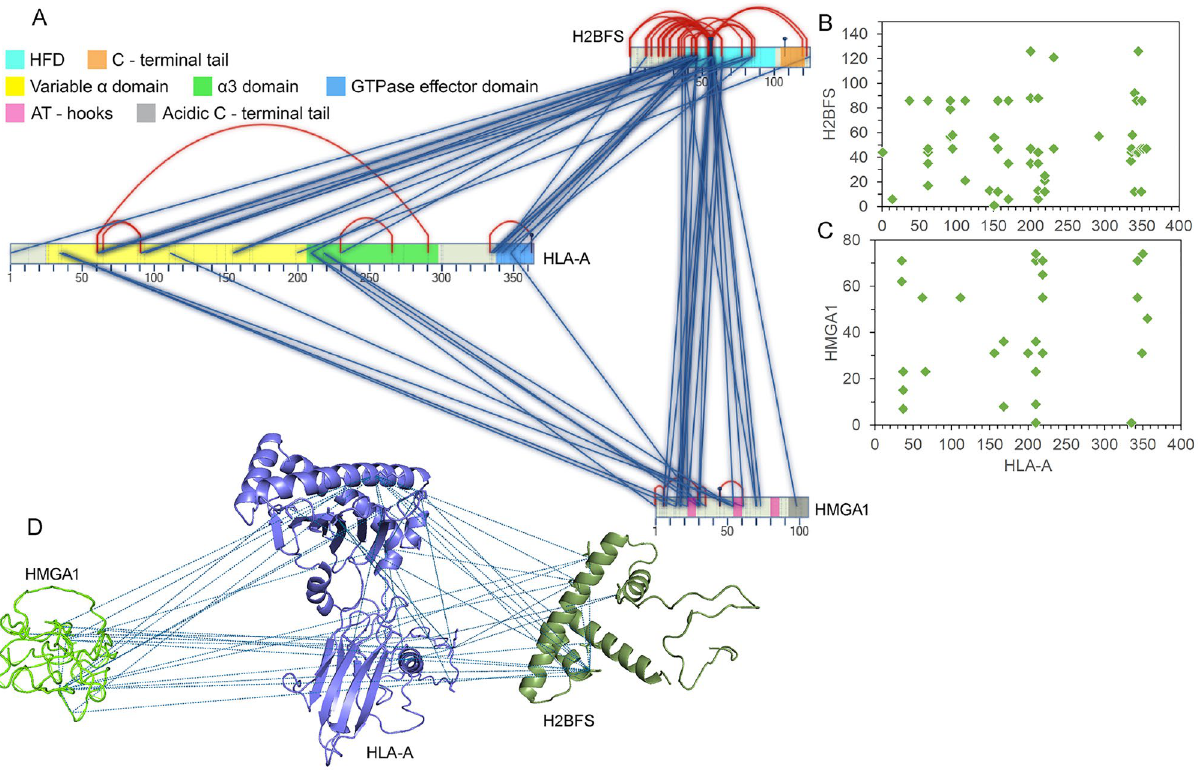
Figure 5. The IFNα induced interaction network of HLA-A with H2B (H2BFS) and HMGA1. (A) 2D map (generated in SIM-XL program 29 ) depicting different types of interaction within the H2B-HLA-A-HMGA1 complex; inter-link (blue), intra-link (red) and mono-link (black). Domains of different identities are labeled with their respective colors 32 : H2B (histone; 2–102) and MHC-I (MHC_1; 25–203, C1-set; 210–290, and MHC_I_C; 337–364). The cross-link score cut-off was set to 3.5. Dot plots representing interaction sites of HLA-A with H2B (B) and HMGA1 (C) , with interaction site K or S between two peptides. In the plots, the cross-link score cut-off was set to 3.0. (D) Inter-links between proteins displayed over the H2B, HLA-A, and HMGA1 protein structures in the PyMOL program. These structures were modeled using the Phyre2 server (http:// www. sbg. bio. ic. ac. uk/ phyre2), and the template structures used for the proteins H2B, HLA-A, and HMGA1 were 1kx5 52 , 1kj3 49 , and 2eze 55 ,